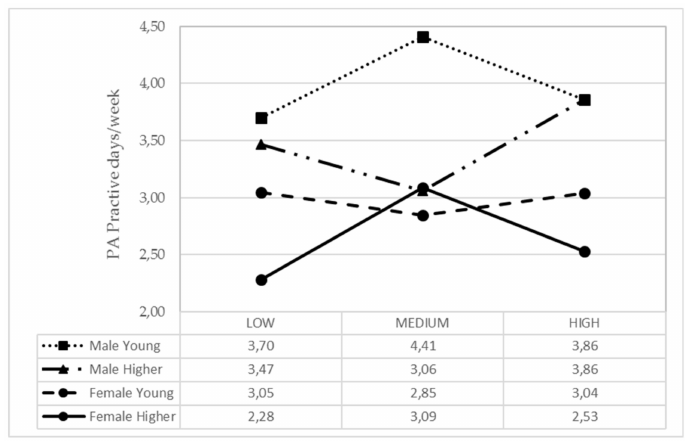
Figure 3. Means of the IPAF3 parental style based on the adolescent gender and age for PA practice.